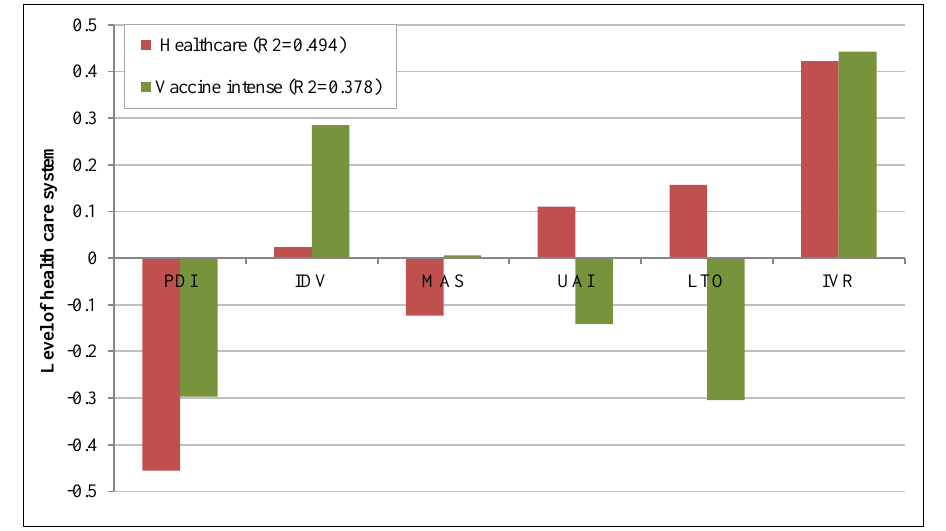
Figure 8. Health care system during